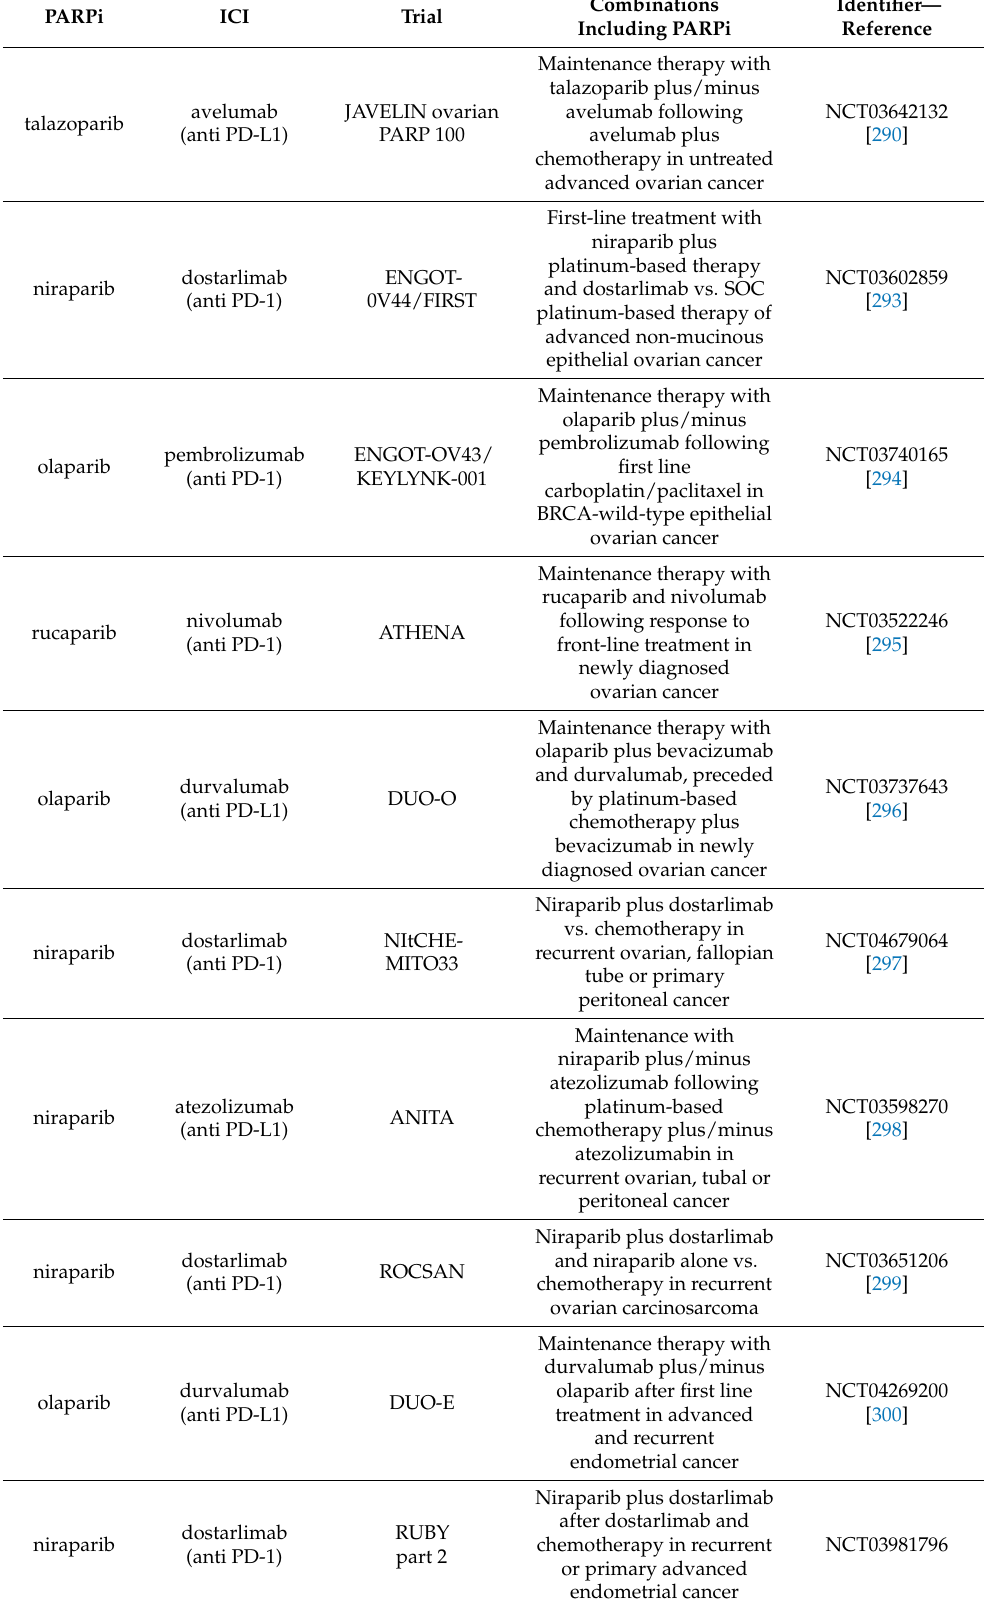
Table 1. Phase 3 clinical trials combining PARPi with